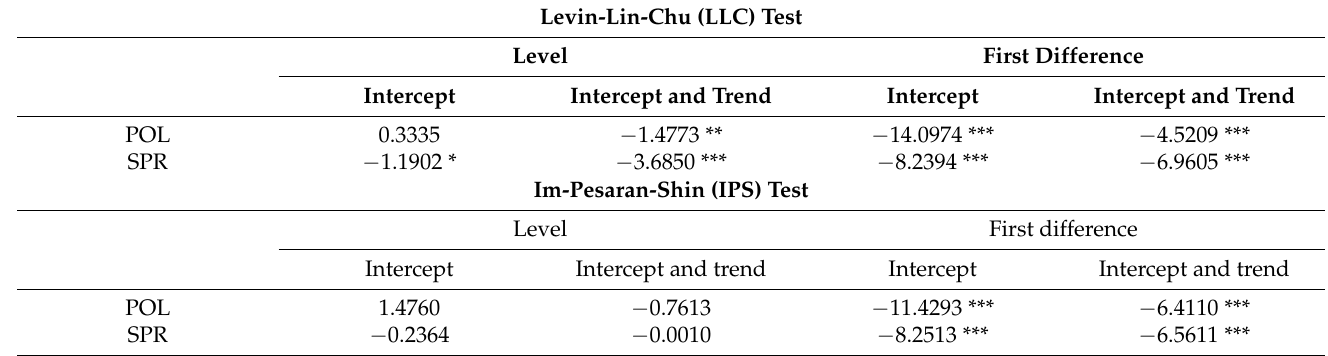
Table 3. Panel-unit root test